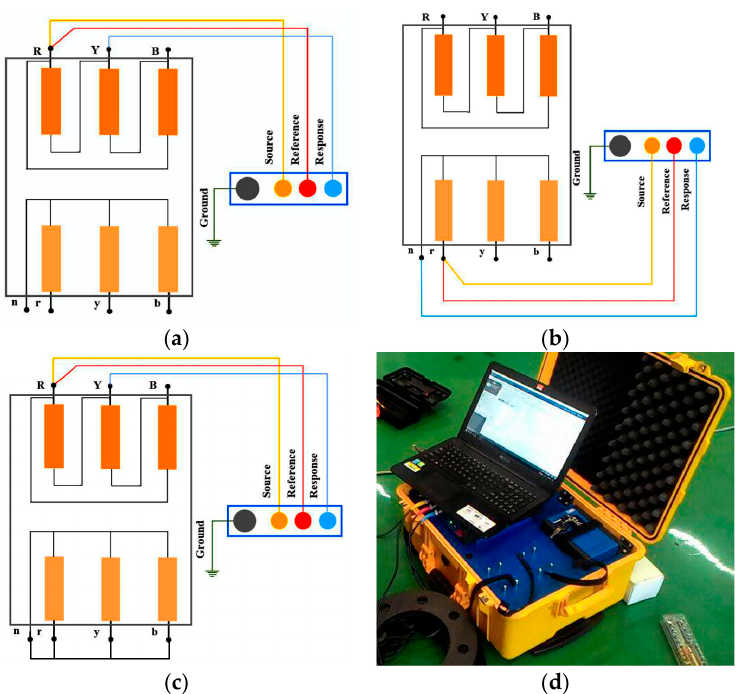
Figure 2. Frequency response analysis (FRA) measurement configurations: ( a ) end-to-end open circuit high-voltage (HV) winding; ( b ) end-to-end open circuit low-voltage (LV) winding; ( c ) end-to-end short circuit HV; ( d ) FRA analyzer.